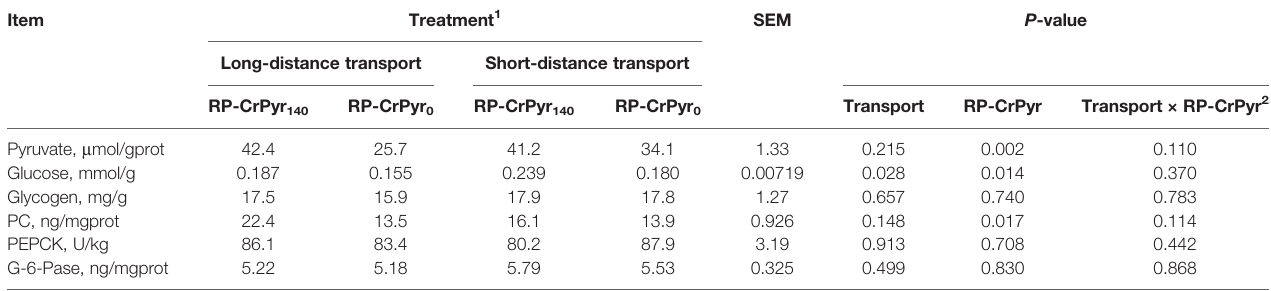
TABLE 6 | Effects of transport and rumen-protected creatine pyruvate on the hepatic gluconeogenesis of beef cattle. Item Treatment 1 SEM P